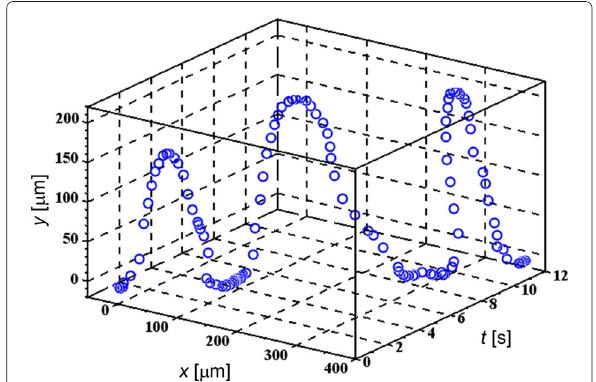
Fig. 2 3D trajectory of a targeted TL cell. Periodic U-turns due to the frequency modulation are demonstrated for the TL cell undergoing the FM-DEP